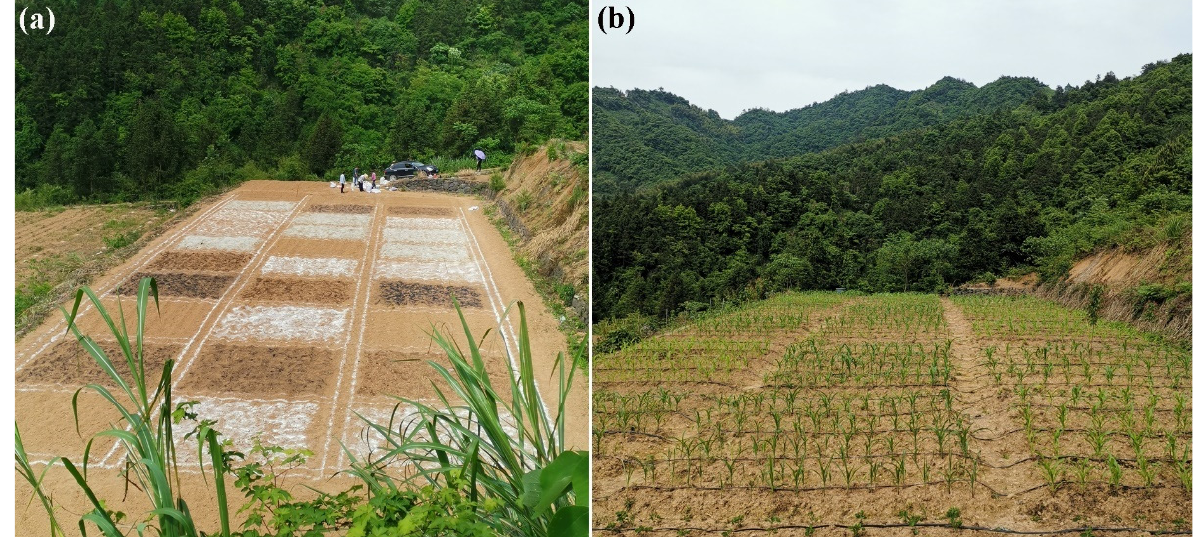
Figure 1. Experimental site for the evaluation of different fertilizers on the growth of corn in newly reclaimed land. ( a ) Soil with different fertilizers; ( b ) plantation of corn.